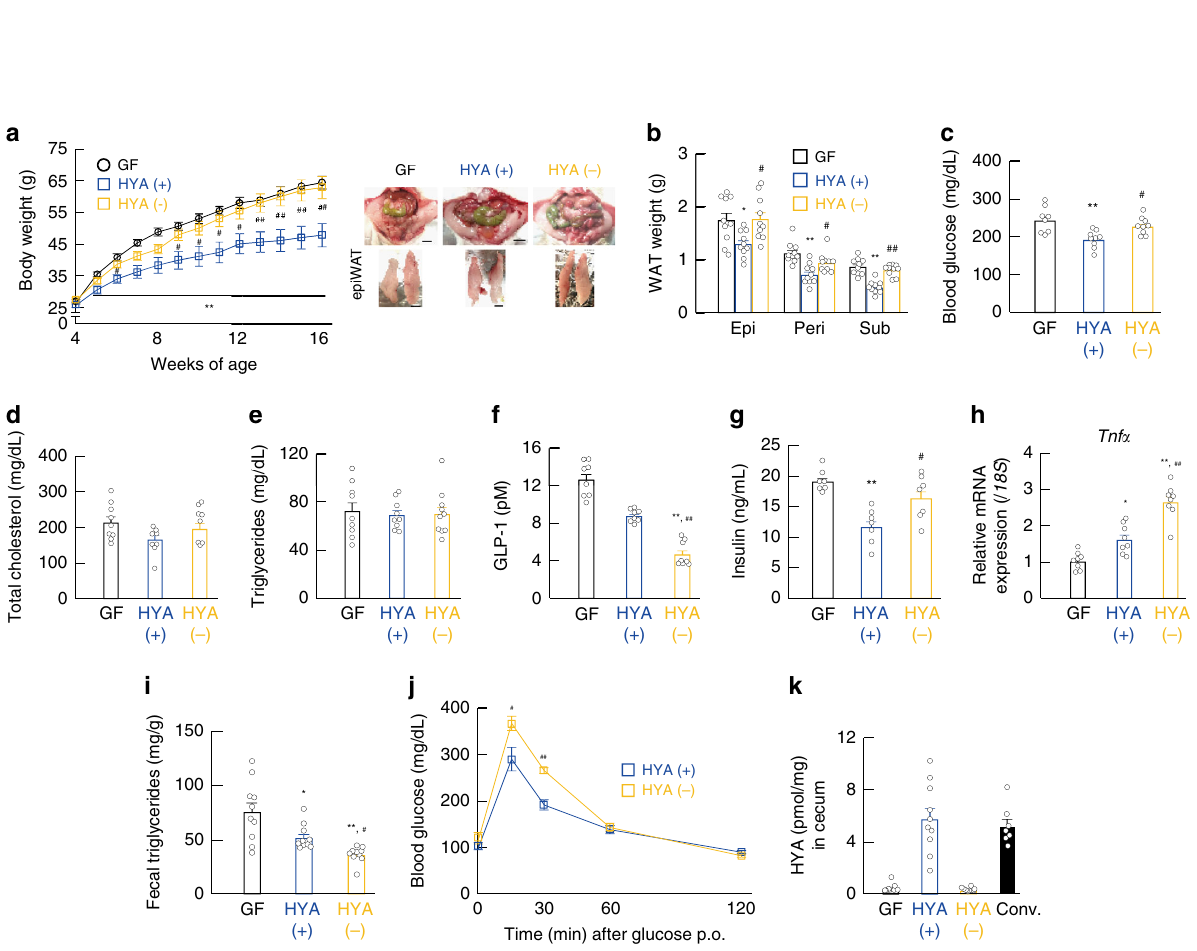
Fig. 7 HYA-producing Lactobacillus contributes to host metabolic improvement. Changes in a body weight ( n = 10, 10, and 8 per group) and b tissue weight ( n = 10 per group) at 16 weeks of age were measured in GF and gnotobiotic mice suffering from HFD-induced obesity. Scale bar; 1 cm. epi, epididymal; peri, perirenal; sub, subcutaneous. c Blood glucose ( n = 8, 9, and 9 per group), d total plasma cholesterol ( n = 8, 7, and 7 per group), e triglyceride ( n = 9, 9, and 10 per group), f GLP-1 ( n = 8 per group), and g insulin ( n = 7 per group) levels were measured at the end of the experimental period. h mRNA expression of Tnf α in the WAT of HFD-induced obesity ( n = 8 per group). i Fecal triglyceride levels were measured at 16 weeks of age ( n = 10 per group). j After colonization of lactic acid bacteria for 1 week, OGTT was assessed ( n = 7 per group). ** P < 0.01; * P < 0.05 vs. GF mice (Tukey – Kramer test). ## P < 0.01; # P < 0.05 vs. HYA ( + ) (Tukey – Kramer test). k Cecal HYA was quanti fi ed in GF and gnotobiotic mice at 16 weeks of age ( n = 9, 10, 10, and 7 per group). Results are presented as means ± SE. Source data are provided as a Source Data fi le